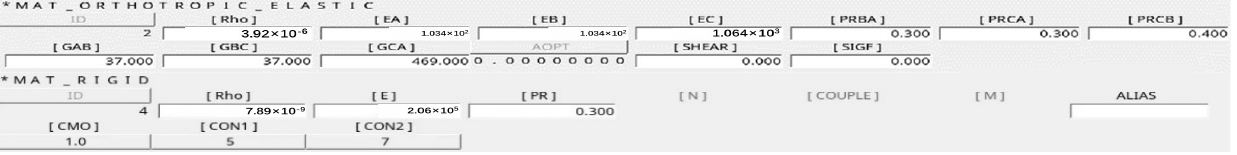
Figure 9. Setting of parameters for citrus fruit stalks and blade models.